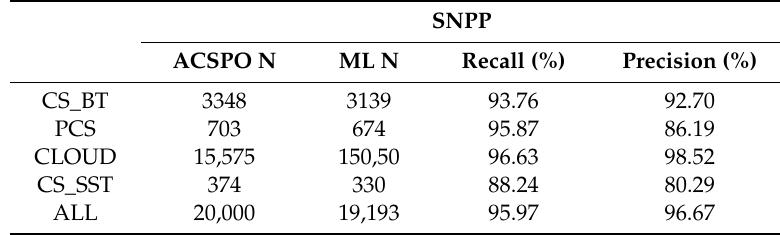
Table 1. The recalls and precisions of the test dataset of four CSM data types.